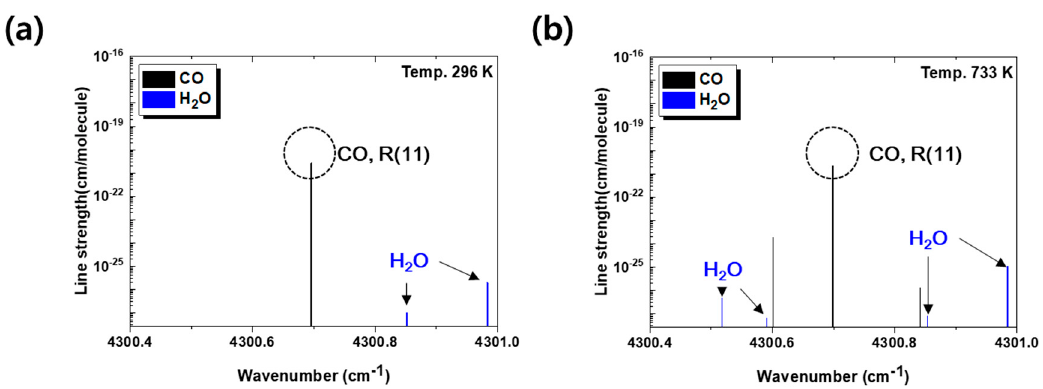
Figure 1. ( a ) Absorption line strength at log-scale of carbon monoxide (CO) and combustion products in the 4300.4–4301.0 cm − 1 spectral range at 296 K and ( b ) absorption line strength at log-scale of CO and combustion products in the 4300.4–4301.0 cm − 1 spectral range at 733 K from the HITRAN database.